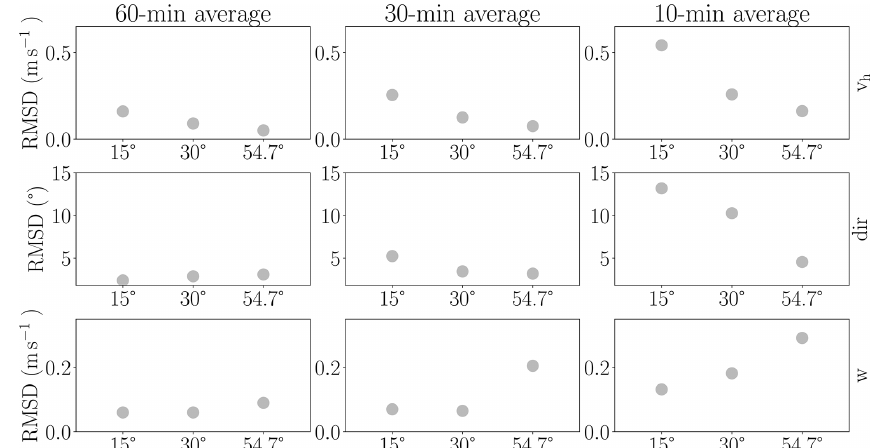
Figure 4. Simulation case 1: RMSD of virtual lidar measurements of wind speed, wind direction and vertical wind with reference to the “true” wind profile of the column located directly above the lidar. RMSD values were calculated over a height interval extending from 50 to 960m for measurements averaged over different time intervals. All values are averages over a 60min measurement period. Thus, there is a single value for the 60min interval, while for the 30 (10)min interval, the value represents an average over two (six) values. Shown are results for measurements obtained with the VAD 24 scan technique at different zenith angles (15, 30 and 54.7 ◦ ).